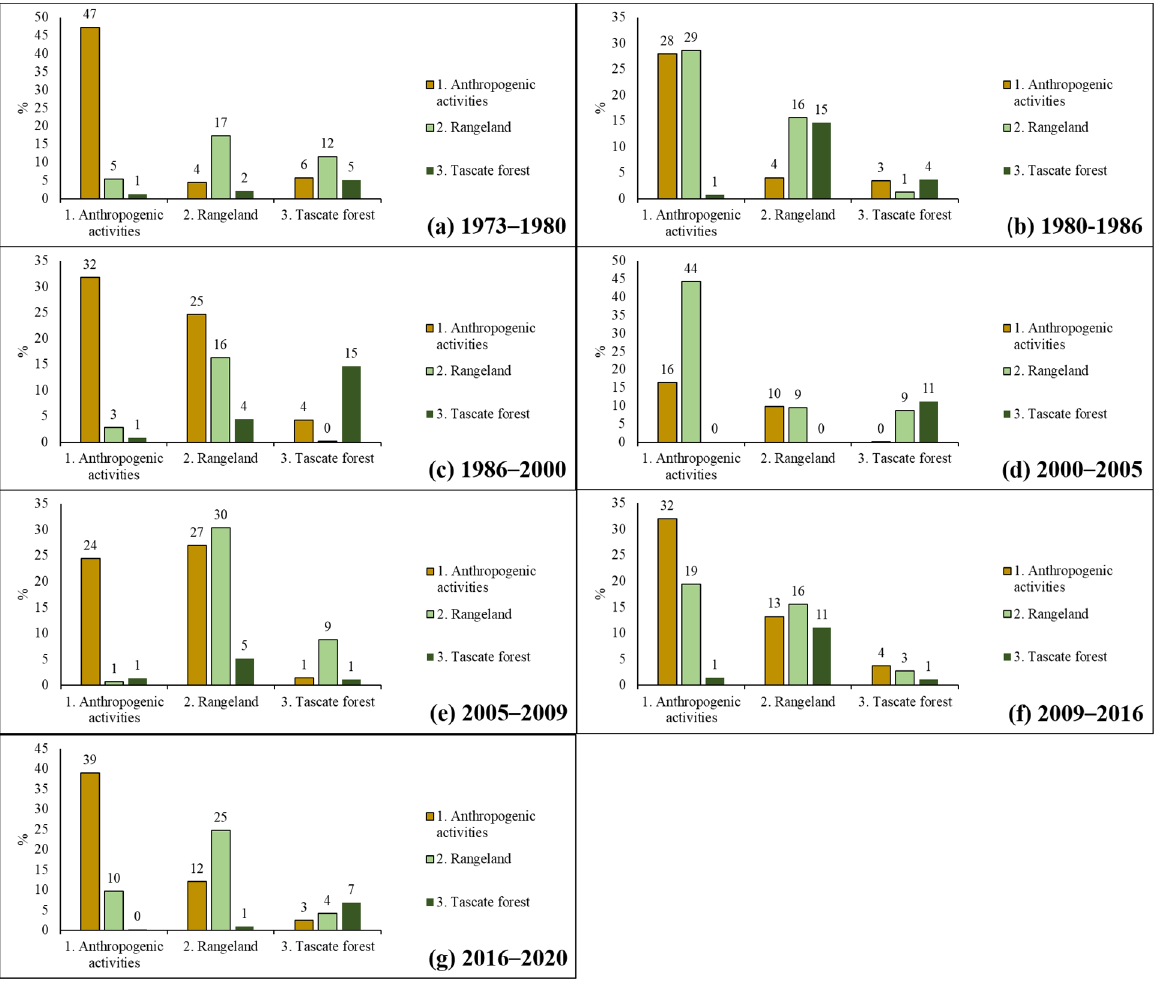
Figure 20. Percentage of land cover changes in scenes from ( a ) 1973–1980, ( b ) 1980–1986, ( c ) 1986–2000, ( d ) 2000–2005, ( e ) 2005–2009, ( f ) 2009–2016, and ( g ) 2016–2020, El Llano y Anexas, Bustamante, Tamaulipas, Mexico.